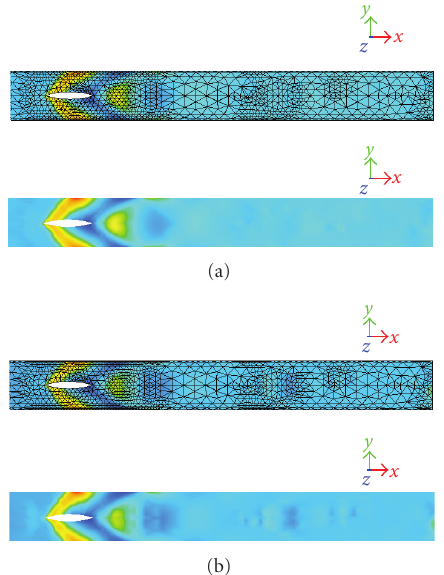
Figure 11: Grids and density solution downstream of the blade— (a) and (b), first step with and without projection, respectively.